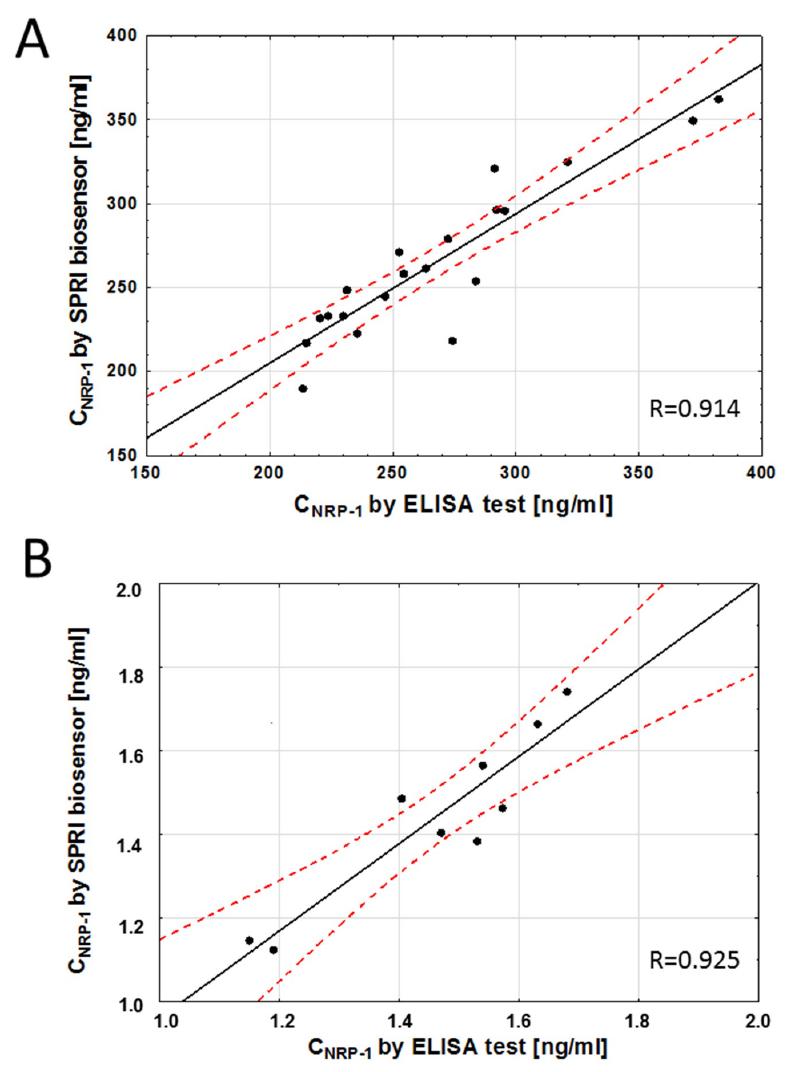
Figure 6. Correlation between serum ( A ) and saliva ( B ) NRP-1 levels quantified with the